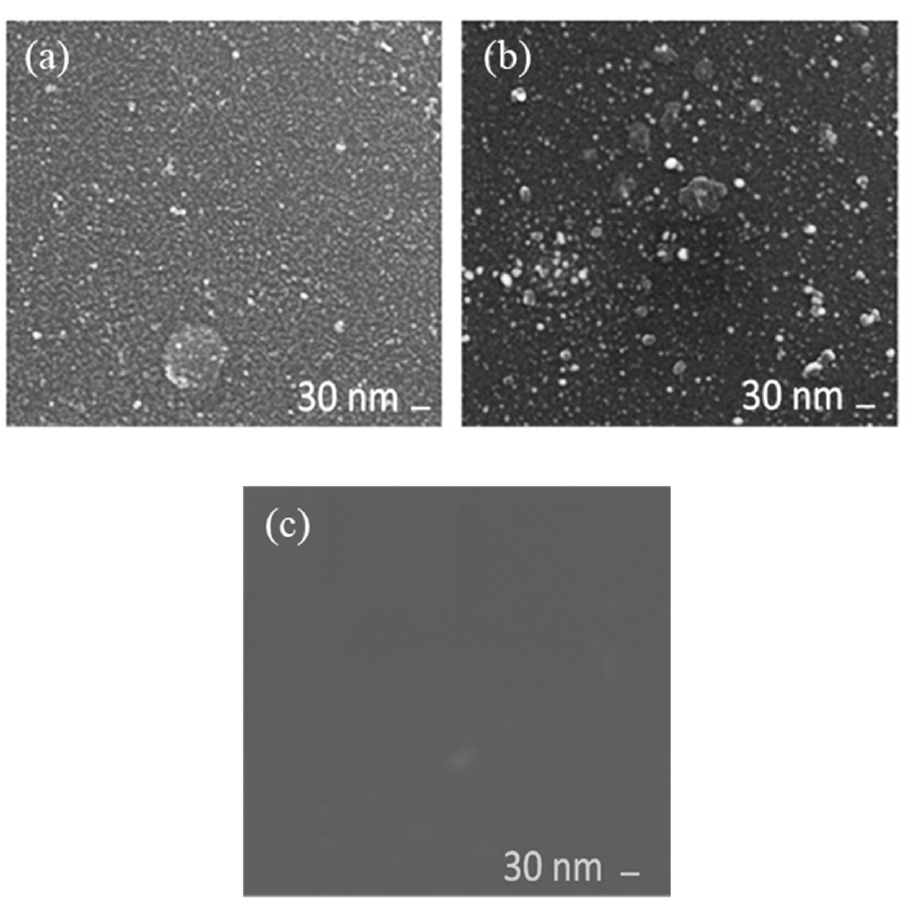
Figure 1. FE-SEM images of the Pt catalyst on the glass fiber substrate: ( a ) before curing, ( b ) after curing, and ( c ) on the glass fiber substrate without the 3-mercaptopropyltrimethoxysilane (MPTS) monolayer after the Pt nanoparticle treatment. Table 1. Precious metal loading rates (precious metal particle weight / catalyst weight × 100) of the catalysts.